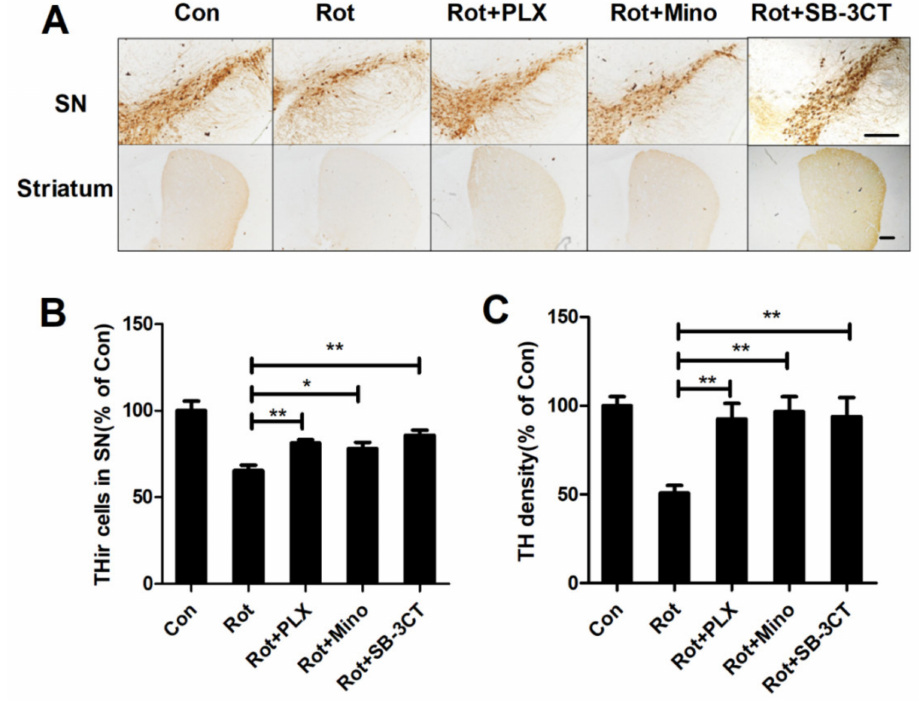
Figure 6. PLX3397, minocycline, and SB-3CT mitigate rotenone-induced dopaminergic neurodegen- eration in mice ( A ) Representative images for TH staining in the SN and striatum of mice. ( B ) The quantification of number of TH + neurons in the SNpc. ( C ) The quantification of density of TH staining in the striatum. n = 4. * p < 0.05, ** p < 0.01; scale bar = 200 µ m. Con: vehicle-treated mice group;